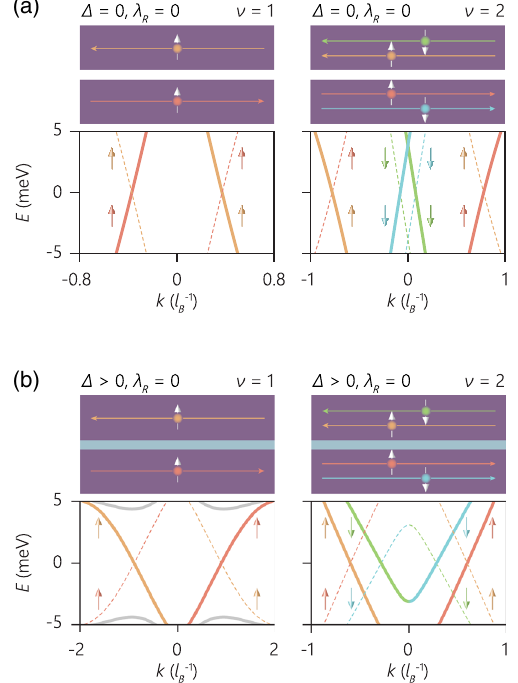
FIG. 7. Evolution of Bogoliubov – de Gennes spectrum when including superconductivity without spin-orbit coupling. (a) Il- lustration of the edges separated by vacuum for ν ¼ 1 , 2, and their calculated Bogoliubov – de Gennes spectrum. Momentum k in units of l − 1 with l the magnetic length. k to − k symmetry is a B B result of physical ( Z 2 ) symmetry — a reflection with respect to the separating vacuum [or superconductor for (b)], which exchanges the left mover and the right mover. Spectrum is doubled to show both electronlike (solid lines) and holelike (dashed lines) ex- citations. Color code indicates the spin and the direction of propagation. (b) Inclusion of superconductivity ( Δ > 0 ) without ¼ 0 ) does not affect the spin polarization. spin-orbit coupling ( λ R This leaves the zero-energy crossings spin polarized, which cannot be gapped by an s -wave superconductor — an induced on the inter- CAR pairing gap Δ does not open. (b) Same as Fig. 2(c). For these ind simulations and the ones presented in Fig. 2, the system parameters are set as follows: Δ 1 ¼ 0 . 3 ε 0 , Δ 2 ¼ 0 . 2 ε 0 ¼ 0 for vacuum), m ¼ 3 ε ¼ 0 . 06 ε μ ¼ 8 ε ( Δ 1 0 , m n 0 , ; 2 s s